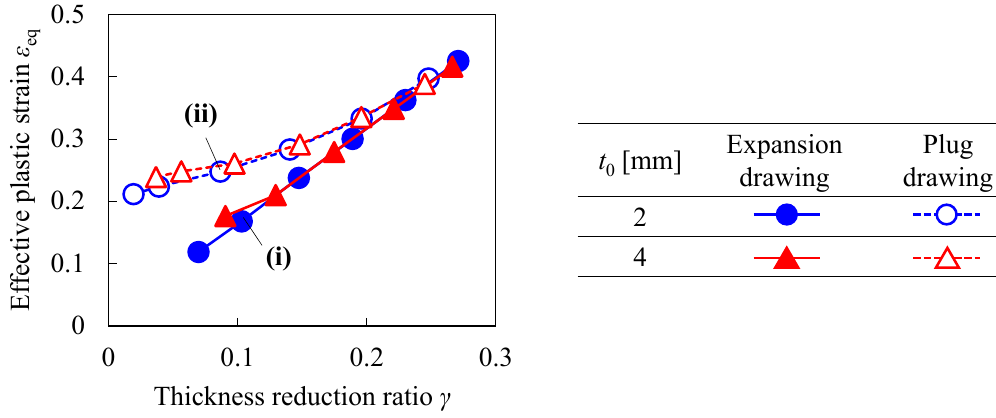
Figure 12. Relationship between effective plastic strain ε eq and thickness reduction ratio γ (STKM13C, 2D FEM).